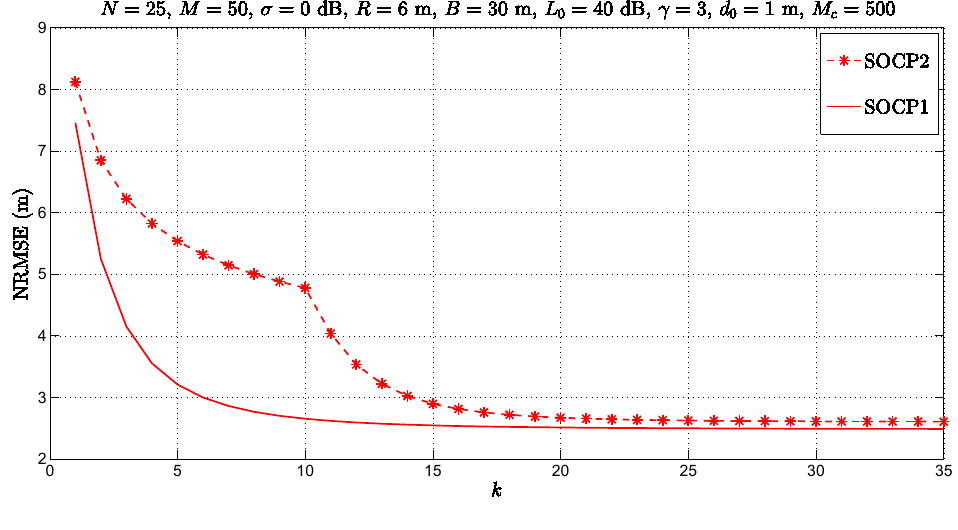
Figure 9. Simulation results for cooperative localization for known and unknown L NRMSE versus k comparison, when N = 25 , M = 50 , σ = 0 dB, R = 6 m, B = 30 m, L = 40 dB, γ = 3 , d = 1 m, M = 500 0 0 c